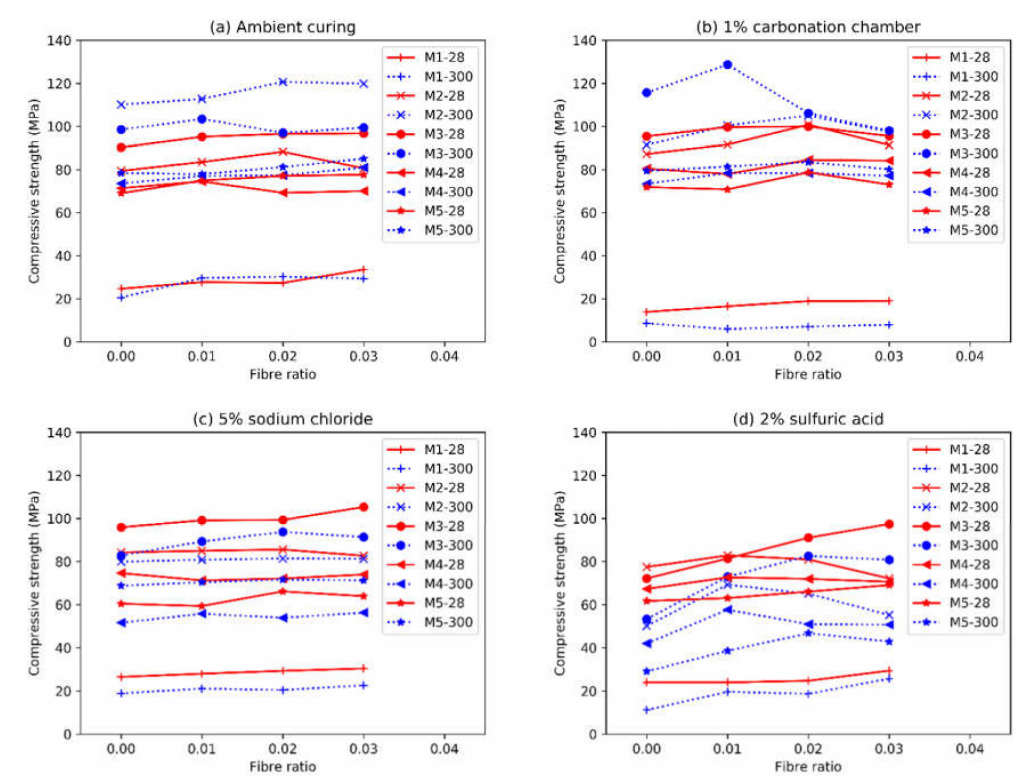
Figure 5. The compressive strengths of the specimens at 28 and 300 days in ( a ) ambient curing room, ( b ) carbonation chamber, ( c ) open-air sodium chloride baths, and ( d ) sulfuric acid